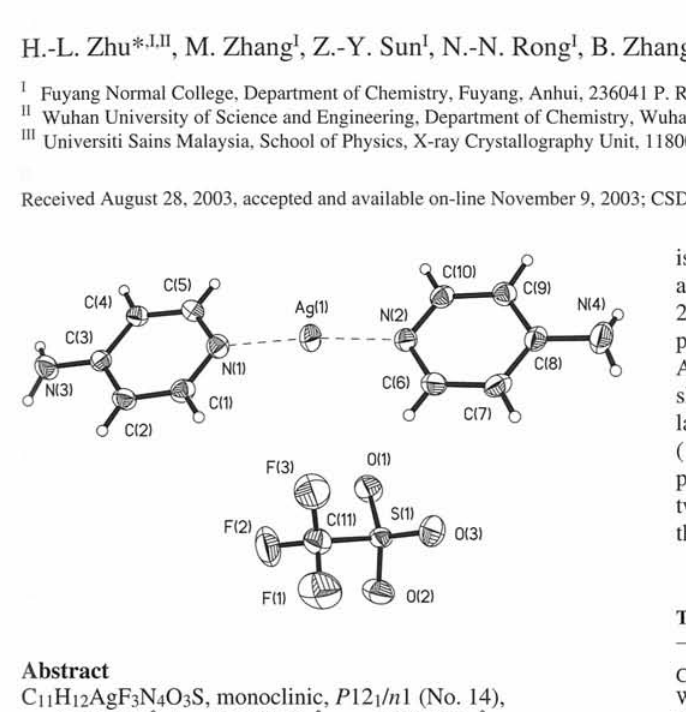
Table 2. Atomic coordinates and displacement parameters (in